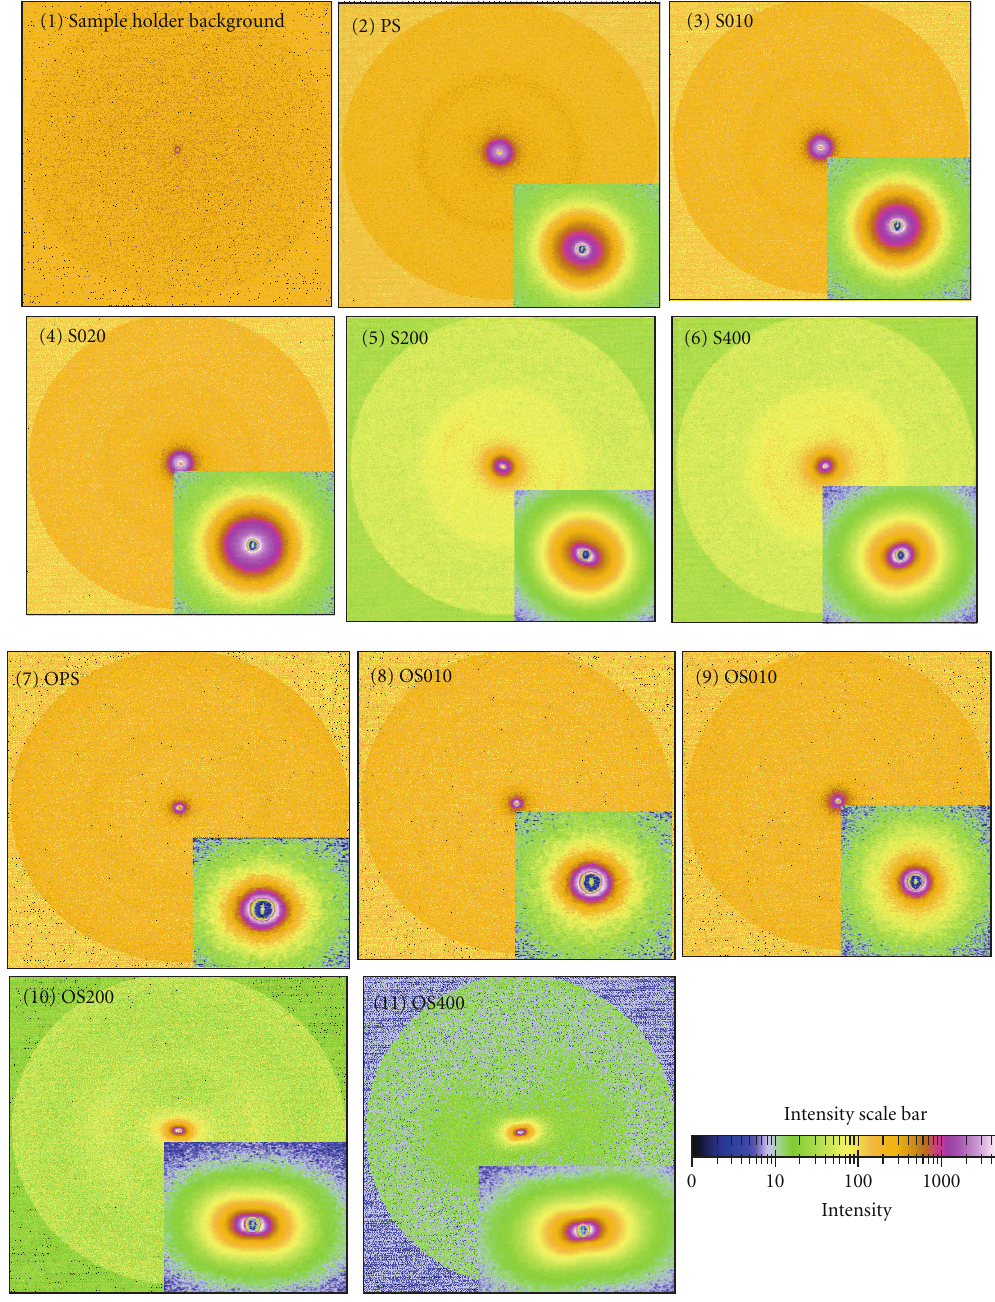
Figure 1: Raw di ff raction patterns for pure starch, starch/sorbitol, and starch/nanoclay samples. (2)–(6) are high-moisture-content samples and (7)–(11) are low-moisture-content